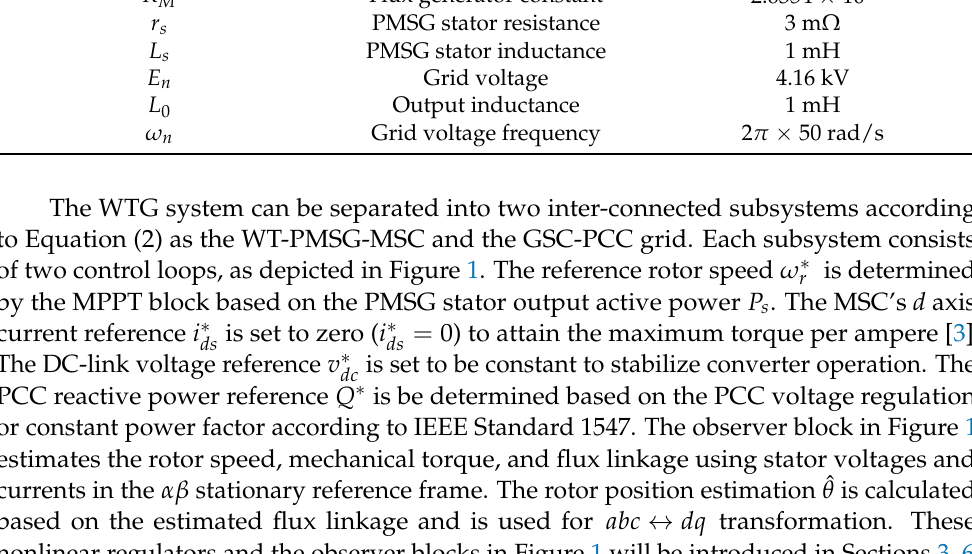
Table 1. Parameter discription of the wind turbine generator (WTG) model. Symbol Quantity Value J Rotor inertia 1.06 × 10 7 Nm/rad/s 2 F Viscous coefficient 1.417 Nm/rad/s P Number of pole pairs 145 K M Flux generator constant 2.6354 × 10 3 r s PMSG stator resistance 3 m Ω L s PMSG stator inductance 1 mH E n Grid voltage 4.16 kV L 0 Output inductance 1 mH ω n Grid voltage frequency 2 π × 50